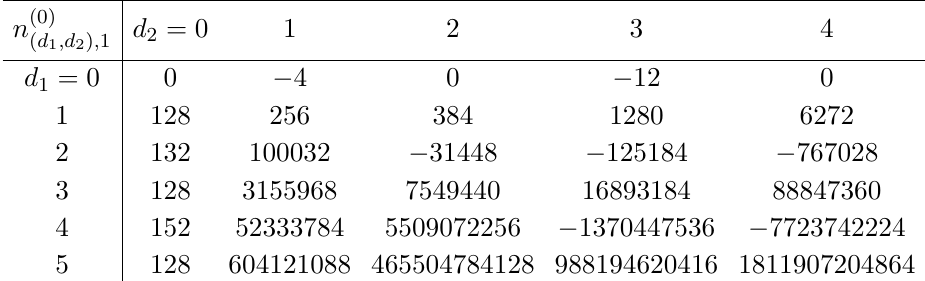
with Z charge 1 2 2